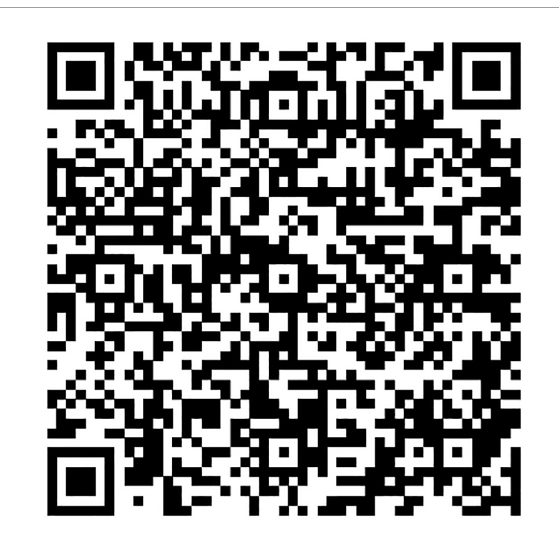
FIGURE7 The QR code of the nomogram for predicting 6-month unfavorable outcome in elderly cohort with aneurysmal subarachnoid hemorrhage (aSAH) who received endovascular coil